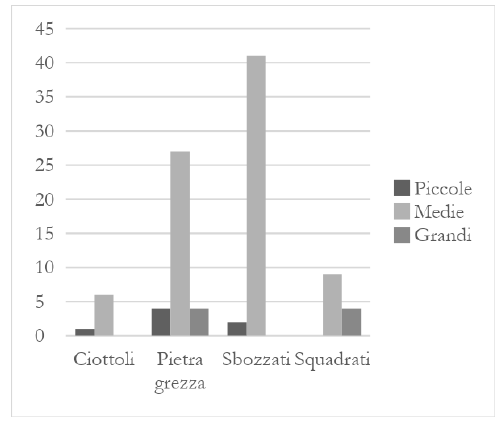
Figure 4. Location of survey.